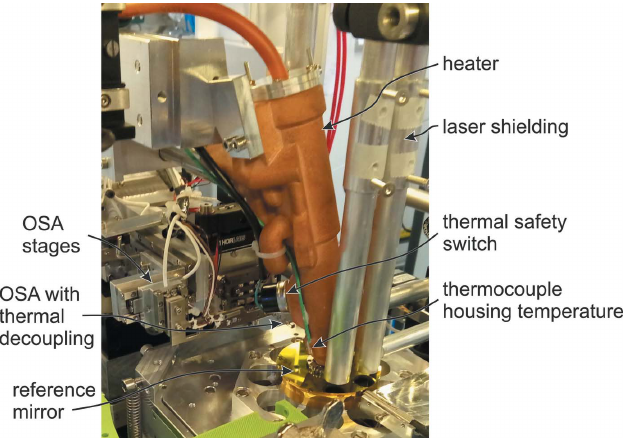
Figure 6 Photograph of all components as installed in flOMNI. The heater is moved down to the measurement position; the OSA has not approached yet and is outside the heater.